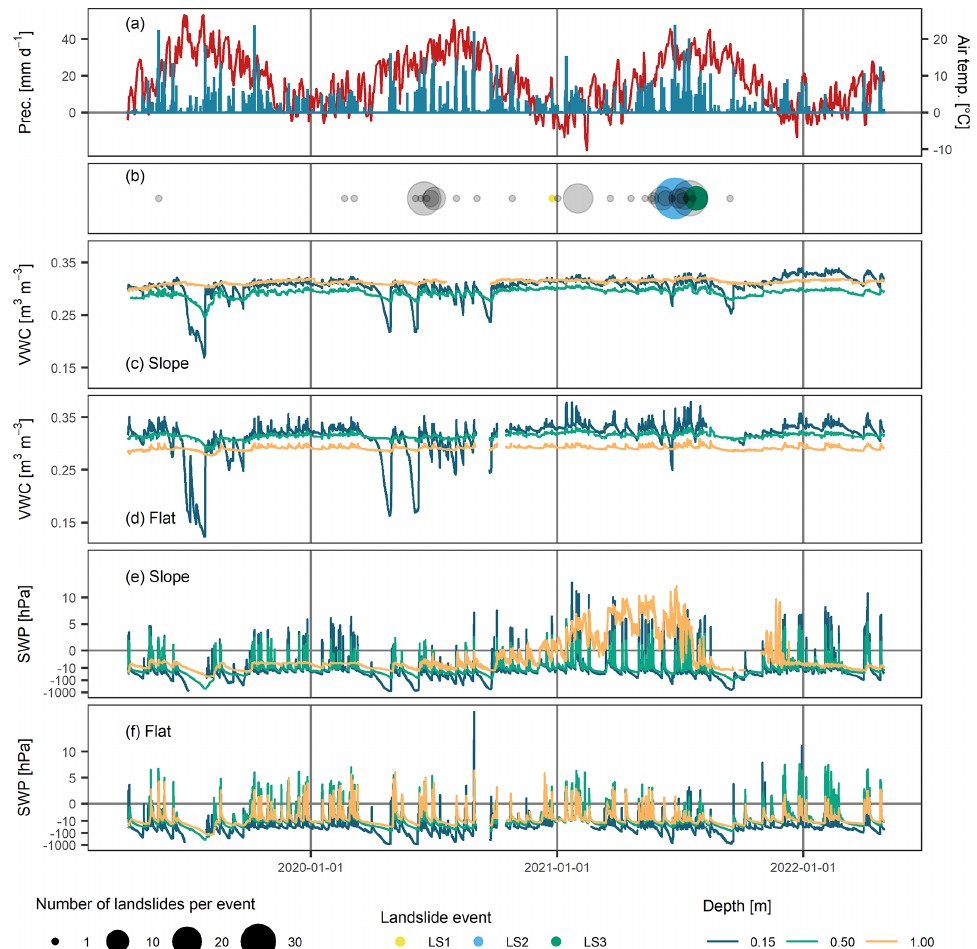
Figure 4. Time series of daily precipitation (blue) and air temperature variation (red) at the sloped site (a) , and number of landslides per event recorded within a distance of 40km from the monitoring sites shown as filled circles of different sizes (b) . The three landslide events LS1, LS2, and LS3 (Fig. 1a) are highlighted in yellow, blue, and green colours, and all other events are shown in gray. Further, hourly variation of VWC at the sloped (c) and flat site (d) , and hourly variation of SWP at the sloped (e) and the flat site (f) at 0.15, 0.50 and 1.00m